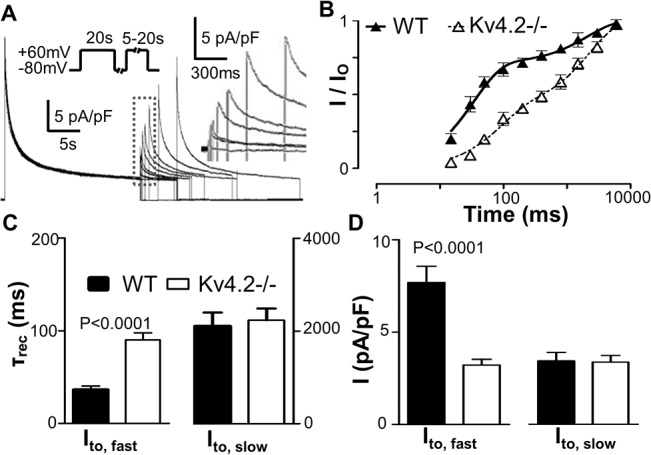
Recovery from inactivation kinetics of Ito (i.e. the fastest inactivation component of the outward K+ currents) in WT and Kv4.2-/-cardiomyocyte.(A) Shows representative K+ current recovery from inactivation recordings from a typical Kv4.2-/- cardiomyocyte. See Methods for the specific protocol. The early portions of traces following the depolarizing test-pulse are re-shown on a faster (expanded to 300 ms/bar scale) time scale in the inset (broken box) to better illustrate the properties of the time-course (of the recovery) of the peaks of the Ito K+ currents as a result of membrane repolarization (to -80mV). (B) This panel shows the normalized Ito current as a function of the pulse interval duration during the recovery from inactivation protocol. The normalized current is defined as the amplitude of the Ito density (i.e. the fastest component) estimated from fits to the currents elicited following depolarization during the recovery period (as described in Fig 1) divided by the Ito density (i.e. fastest component) estimated from fits of the current measured following depolarization during the initial conditioning pulse. Notice that the time course of the recovery of the Ito current shows clear bi-phasic properties, as we described previously, in ENDO cardiomyocytes from WT and Kv4.2-/- hearts. This bi-phasic recovery property of Ito clearly indicates that Ito induced following depolarization is comprised of two underlying currents with different recovery kinetics, a fast recovery component (Ito,f) and a slow component (Ito,s). (C) This shows a summary of the kinetics of the biphasic recovery (i.e. τrec) allowing separation into Ito,f and Ito,s. Note that the τrec for Ito,f is increased and while that for Ito,s is unchanged in Kv4.2-/- compared to WT. (D) Shows the estimated current density of Ito, f and Ito, s calculated from the relative proportions of the Ito recovering quickly or slowly from inactivation, respectively. Note that Kv4.2-/- decreases Ito,f but not Ito, s.